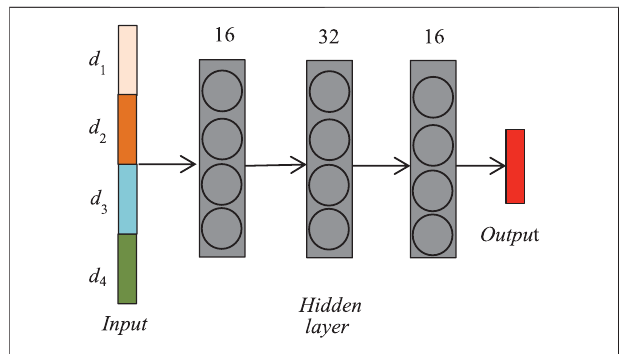
FIGURE 14 | Basic framework of the